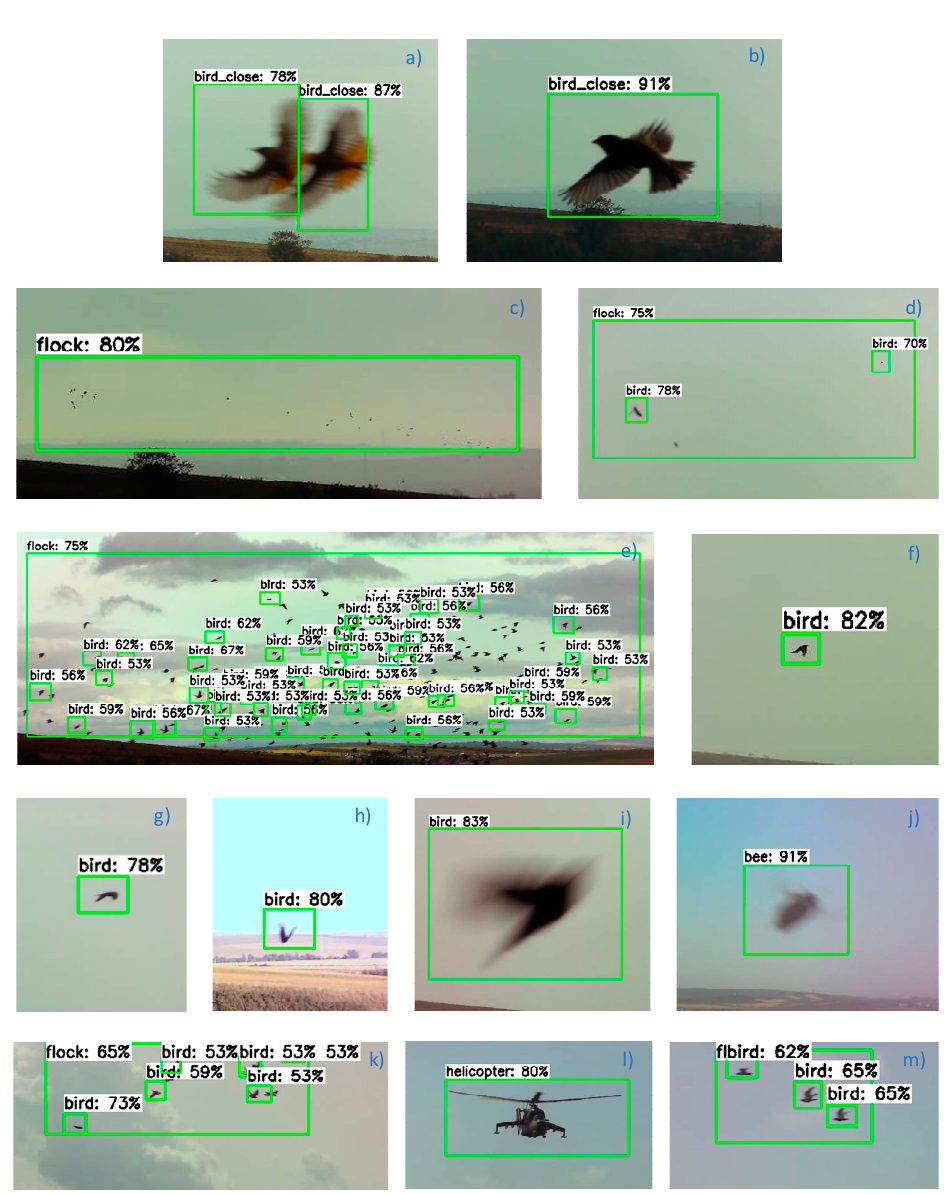
Figure 11. The detection outcomes in individual objects.